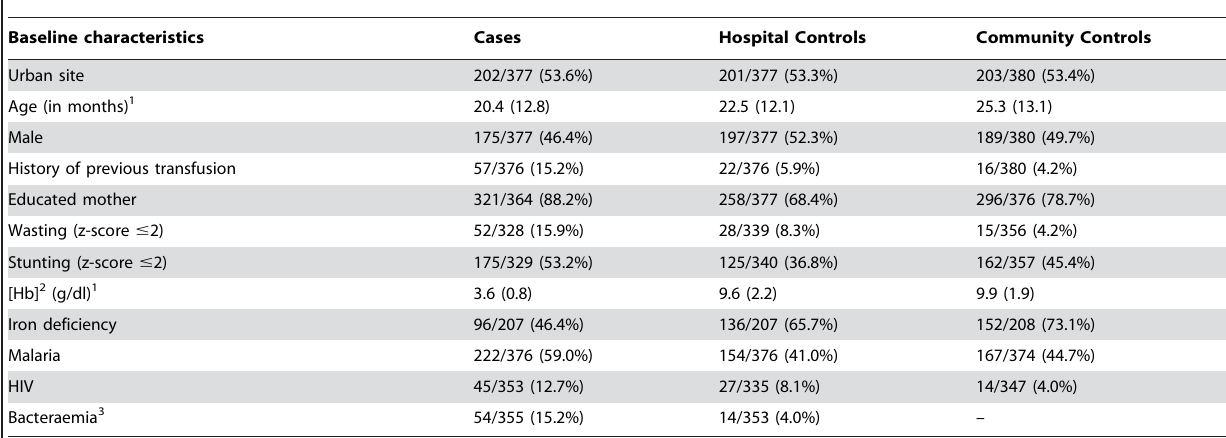
Table 1. Baseline characteristics by study